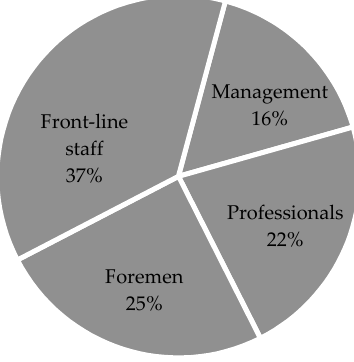
Figure 3. Personnel composition ratio diagram.